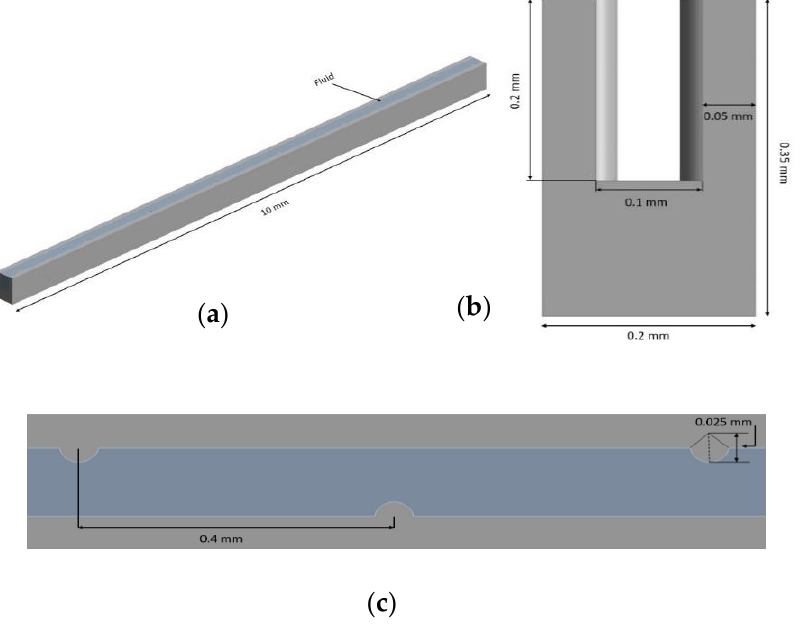
Figure 1. Single microchannel ’ s 3D computational domain having cylindrical protrusion ribs in a staggered manner ( a ) isometric view, ( b ) front view, and ( c ) top view.